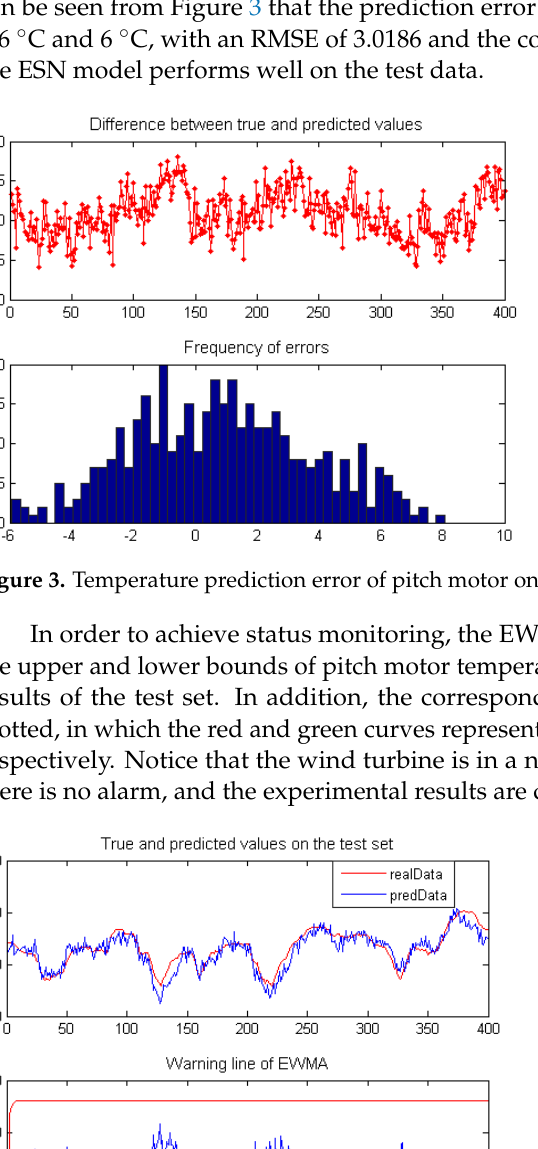
Figure 2. Prediction of pitch motor temperature by ESN model on training data set.